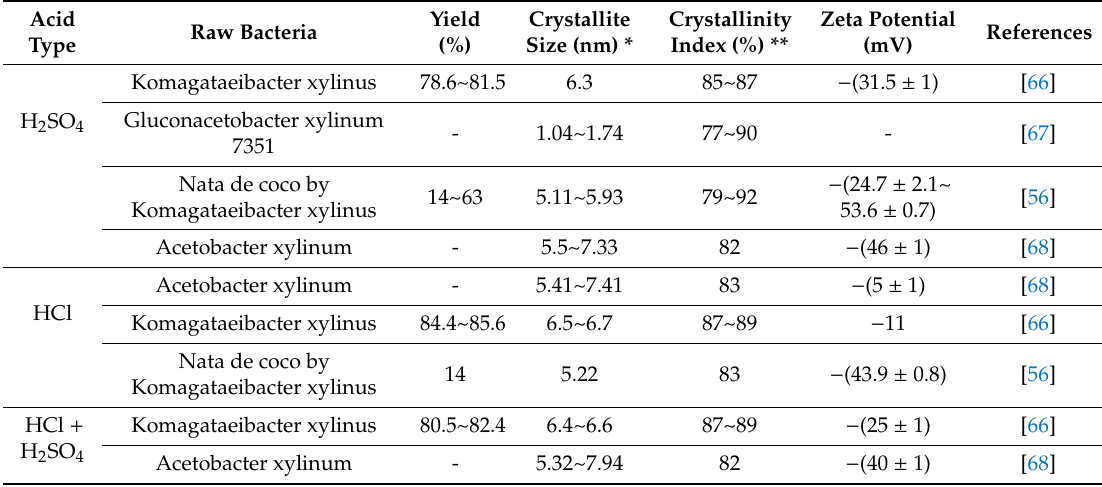
Table 2. The properties of BCNCs from acid hydrolysis.